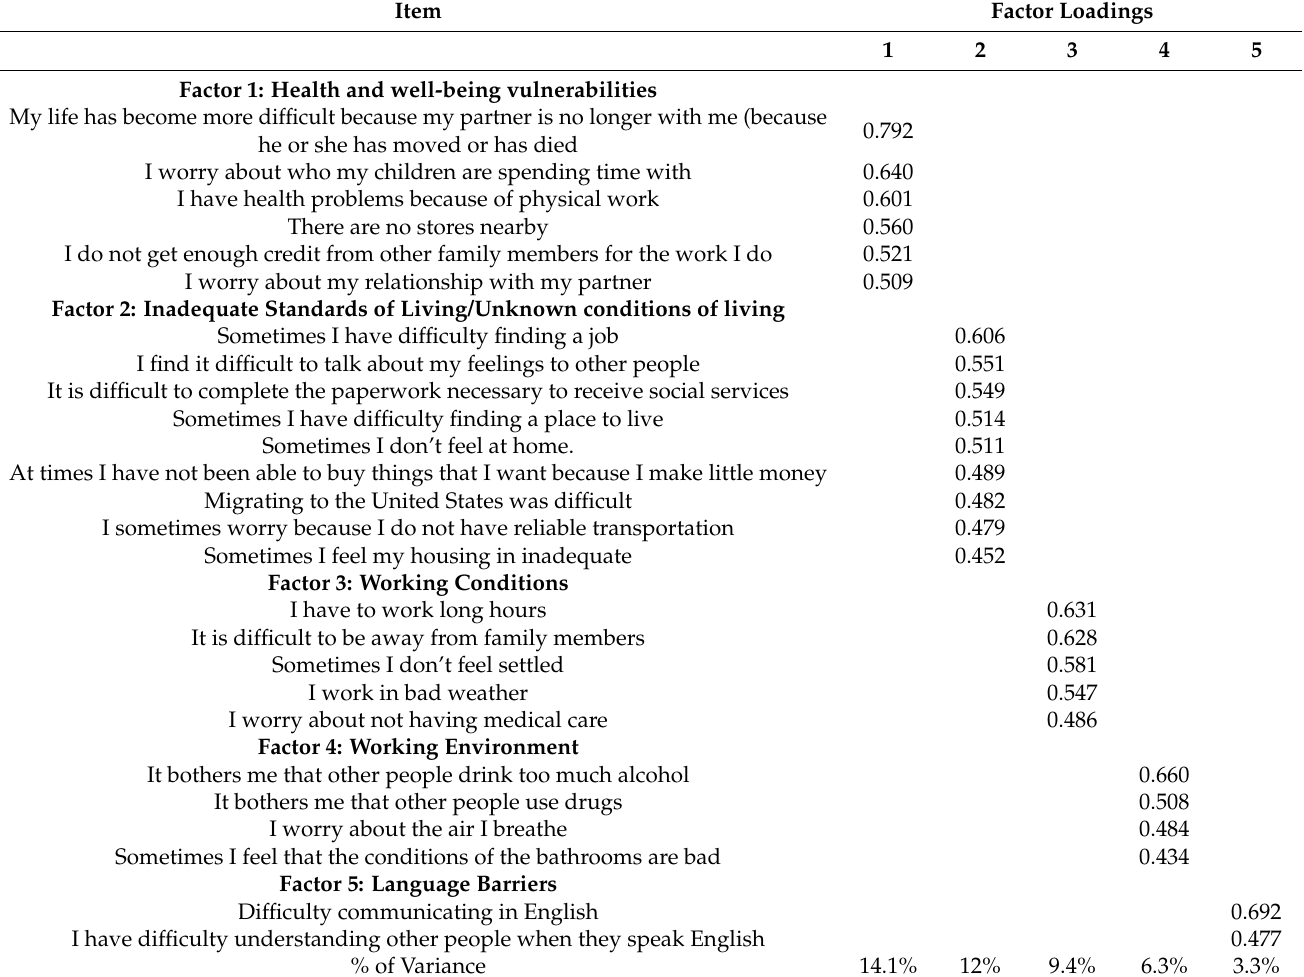
Table 2. Factor loading for the rotated